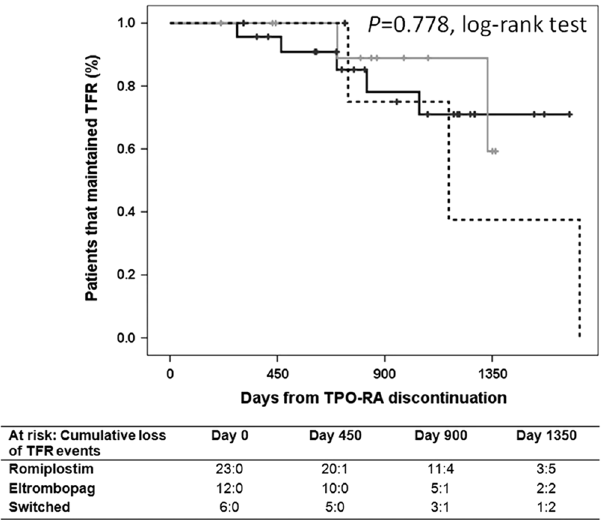
Figure 1. Probability of maintaining therapy free responses (TFR) upon TPO-RA discontinuation. Kaplan– Meier plot showing the estimated probability of TFR in patients who discontinue TPO-RA for reasons other than lack of efficacy and being followed for a minimum of 6 months (n = 41). Patients who died while on TPO-RA therapy were not included in the study. Solid black line represents patients that received only romiplostim (n = 23); solid grey line represents patients that received only eltrombopag (n = 12), and dashed black line represents patients that switched TPO-RA (n = 6). The number of patients that discontinue TPO therapy (“at risk”) and the cumulative loss of TFR events at time points are presented for each group below the figure.